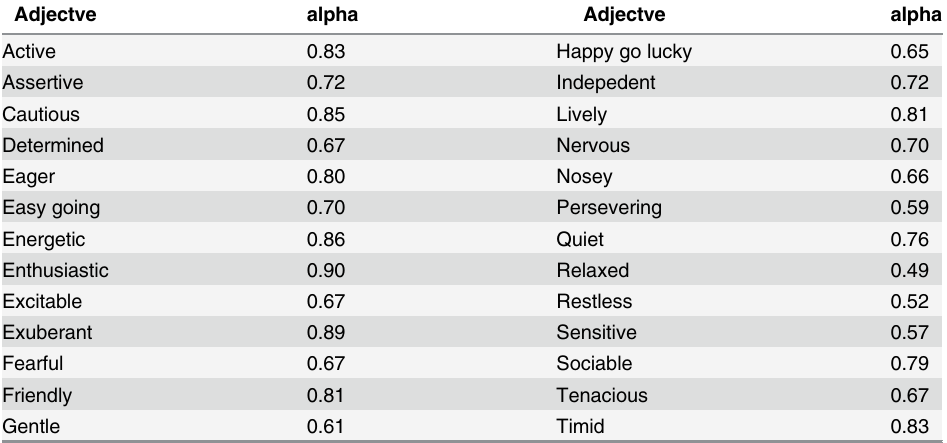
Table 4. Inter-observer reliability measures for each adjective used to assess